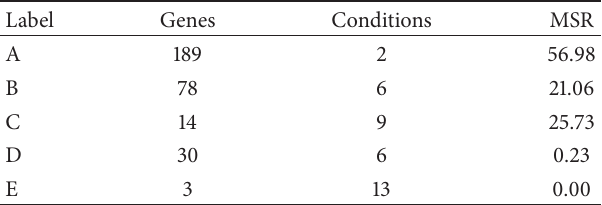
Table 3: Information about bicluster